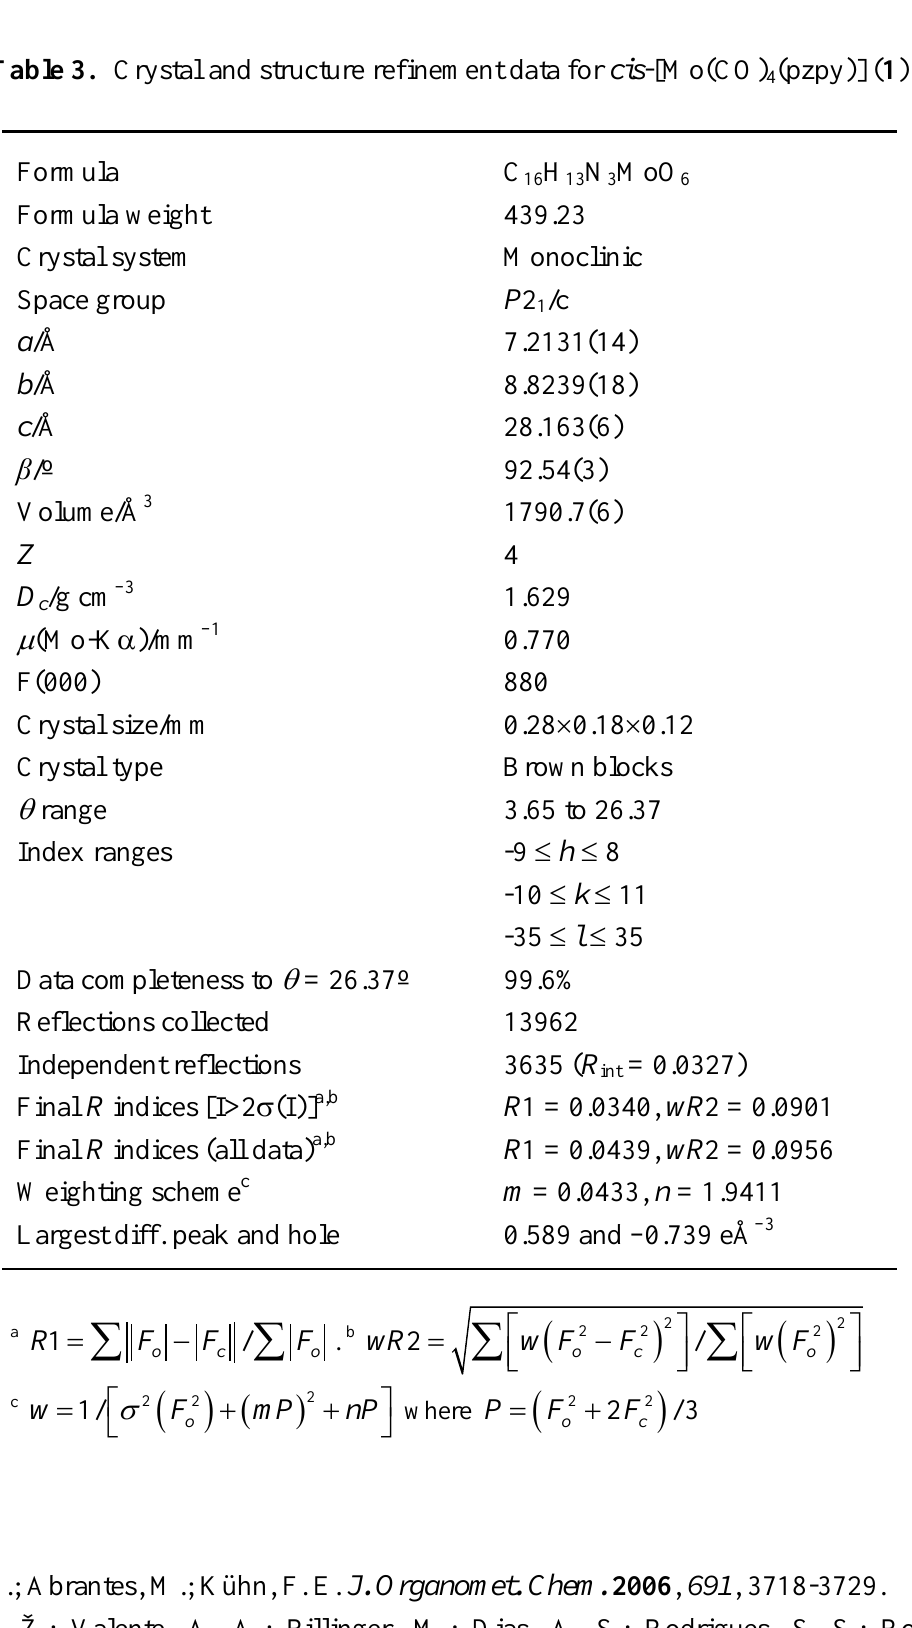
Table 3. Crystal and structure refinement data for cis -[Mo(CO)